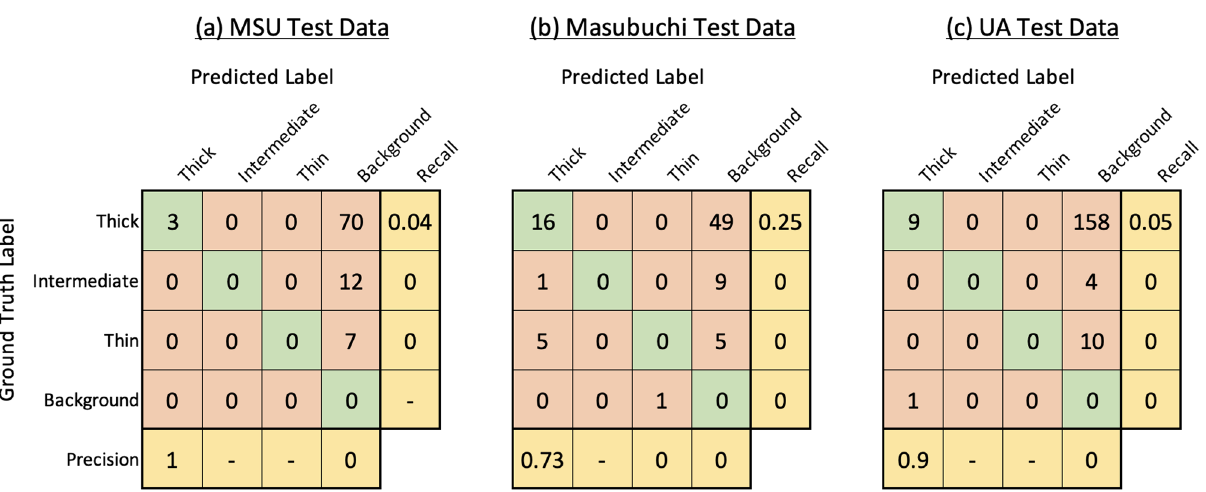
Figure 7. Confusion matrices showing results when applying Masubuchi’s pre-trained Mask R-CNN to our all three test datasets (MSU, Masubuchi, UA). The pre-trained model was unable to identify most manually labeled flakes in the test